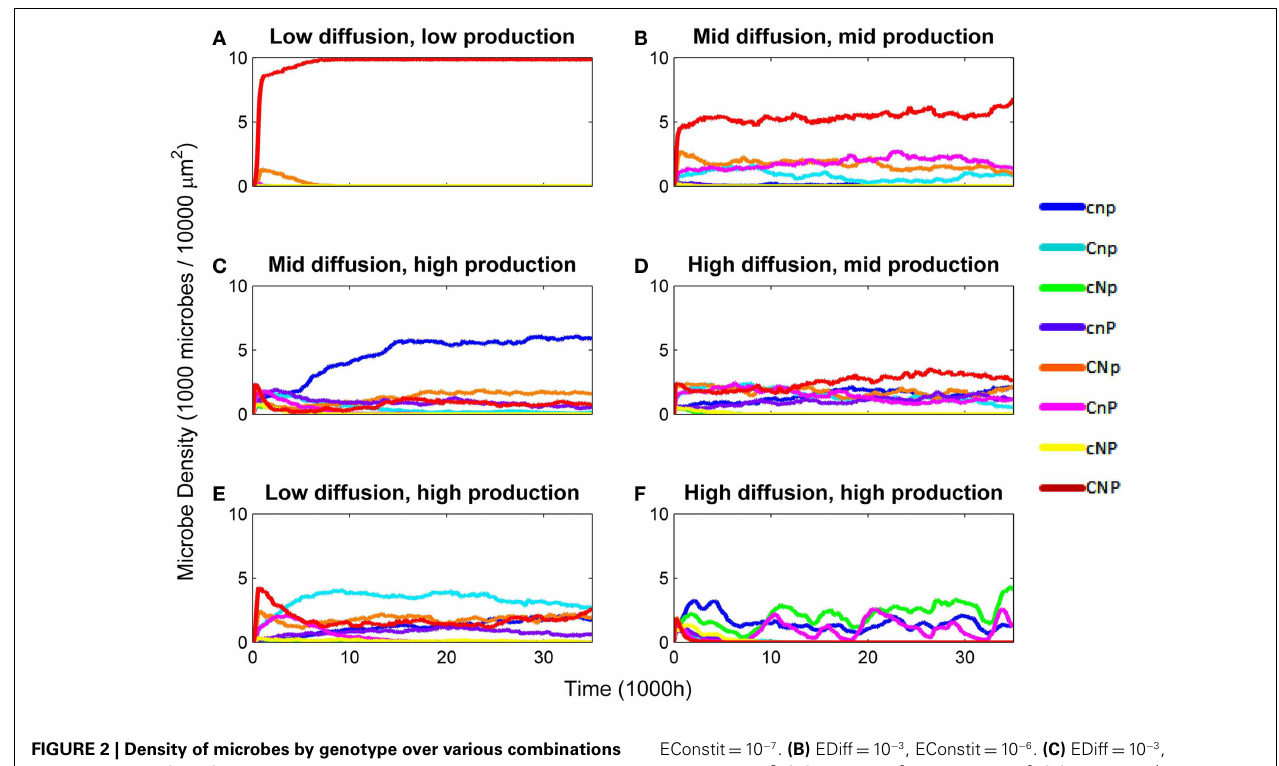
FIGURE 2 | Density of microbes by genotype over various combinations of diffusion rate (EDiff) and constitutive enzyme production rate (EConstit). Densities are in 1,000 microbes/10,000 µ m 2 . (A) EDiff = 10 − 4 ,